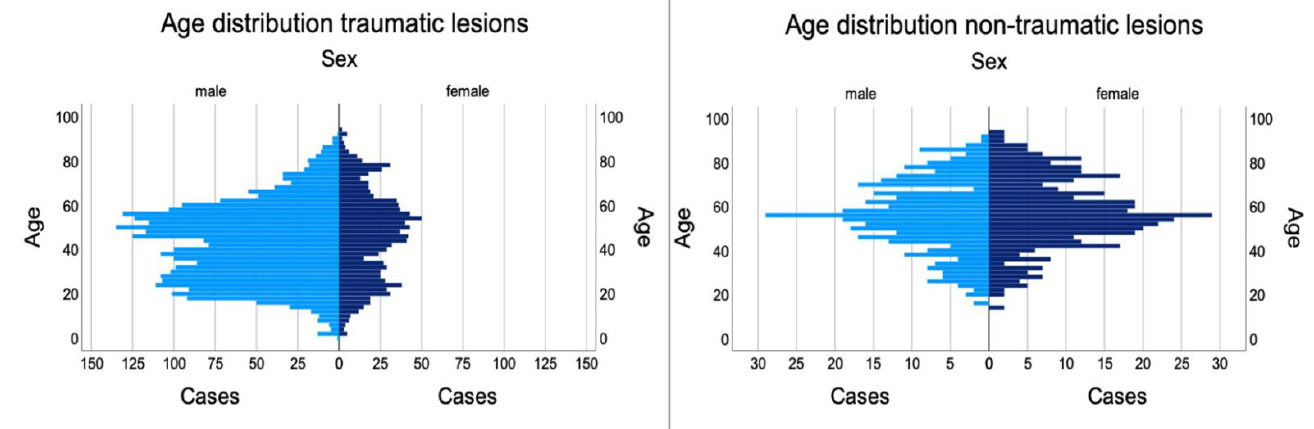
Figure 1. Age distribution of male and female patients suffering from peripheral nerve lesions.